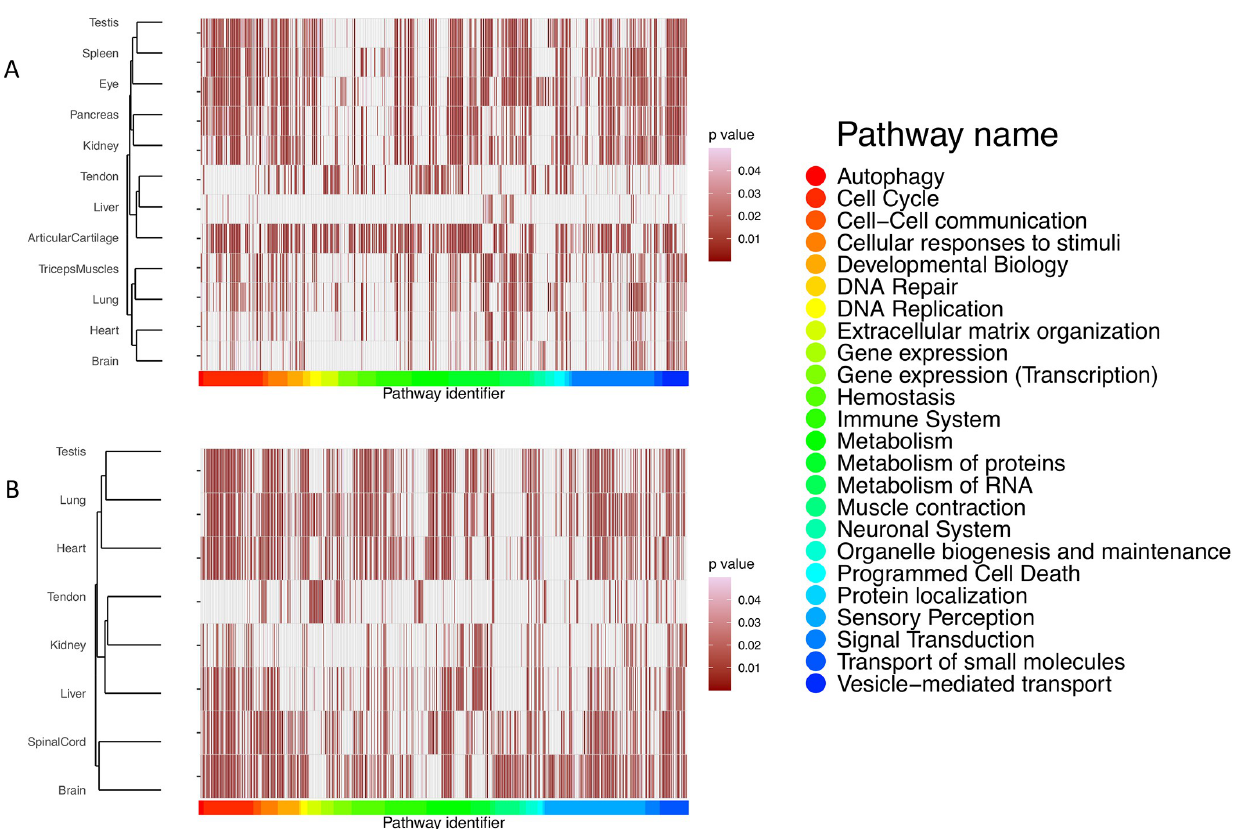
Fig 9. Pathway analysis performed using the canonical proteins, showing the statistically significant representative pathways (p-value < 0.05) in (A) mouse and (B) rat